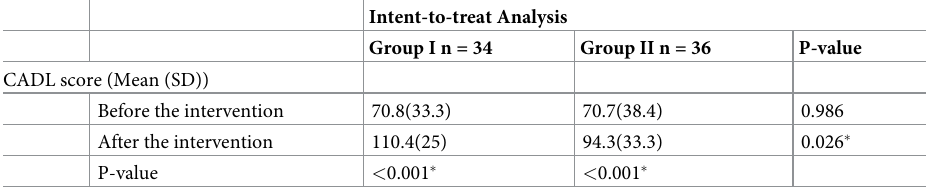
Table 3. Comparison of the CADL scores before and after the intervention in both groups.